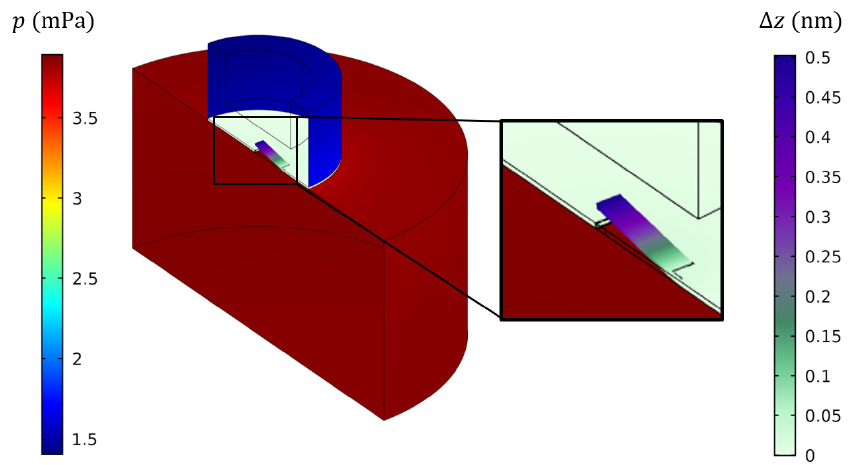
Figure 9. Results of the FEM simulations for the complete PA sensor near the resonance frequency for a deposited power of 1 mW. The left color bar indicates the pressure value in the front volume (dark red) and back volume (blue), while the right color bar indicates the displacement of the cantilever.